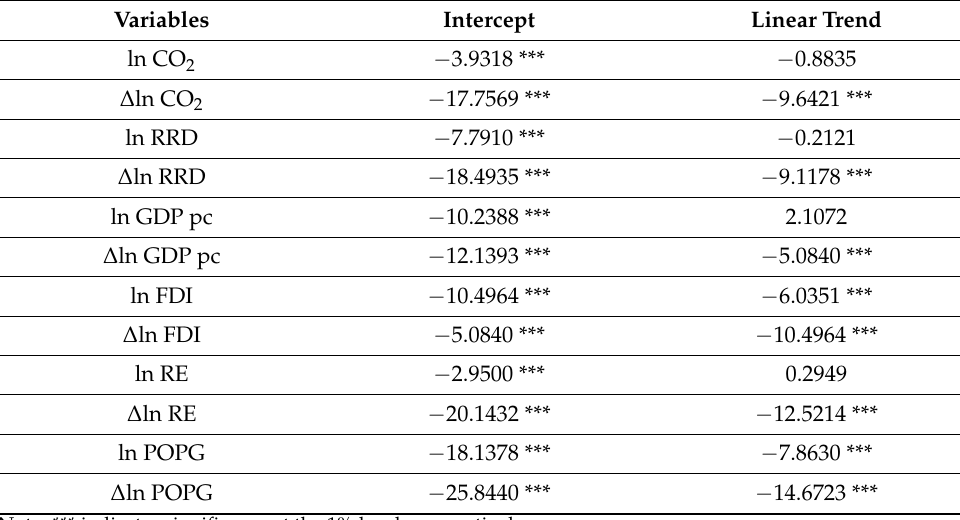
Table 3. Karavias and Tzavalis’ panel unit root test with structural breaks.